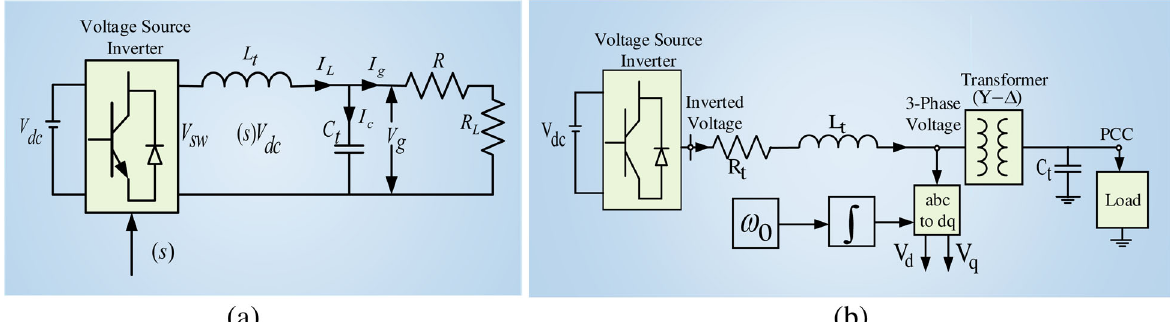
Fig. 12 ( a ) Single Phase Single Energy Source Microgrid System, ( b ) Three Phase Single Energy Source Microgrid